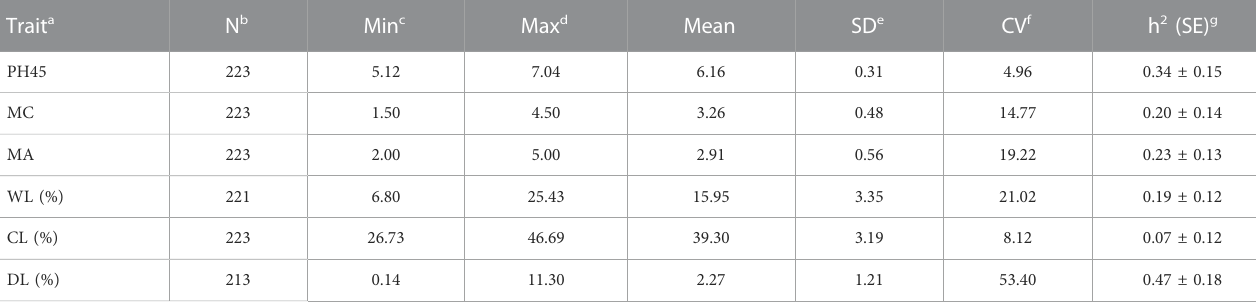
TABLE 1 Phenotype and heritability statistics for six meat quality traits in crossbred pigs. Trait